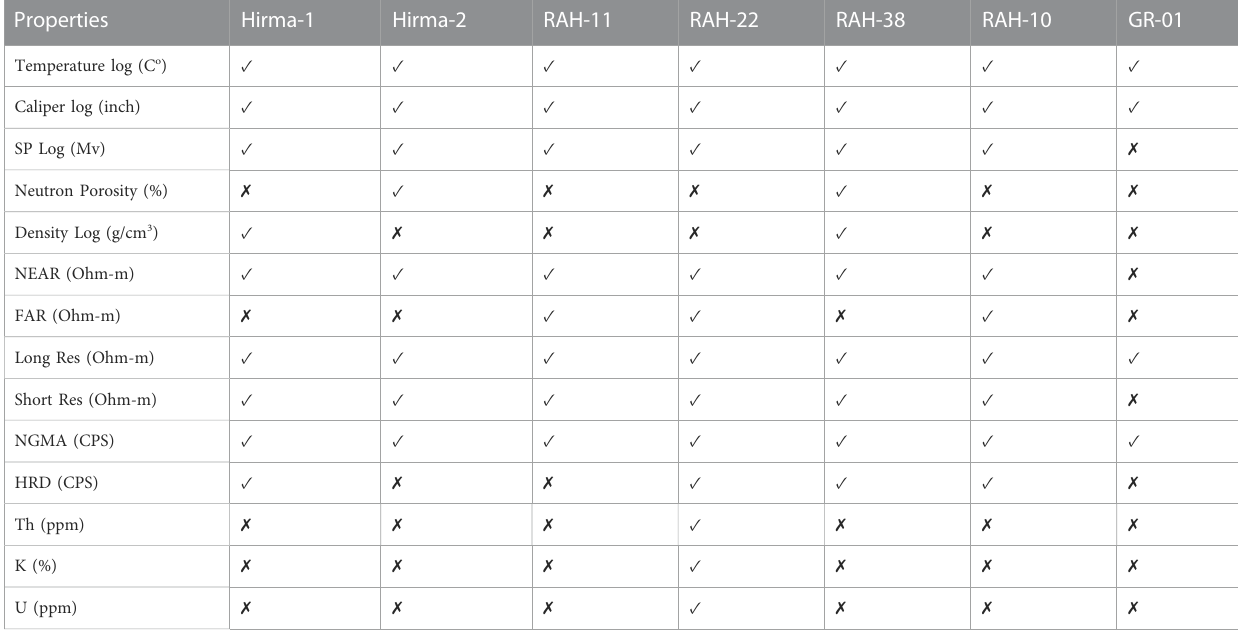
TABLE 2 Available log curve in an available well of Rahat Volcanic Field.